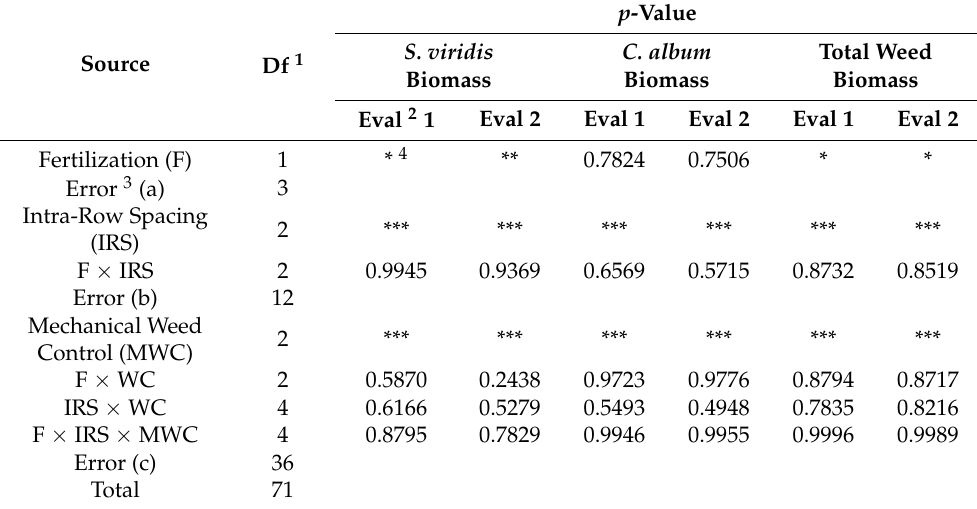
Table 2. The effects of fertilization, intra-row spacing, and mechanical weed control on the biomass of Setaria viridis (L.) P.Beauv. and Chenopodium album L., and total weed biomass. For each parameter, p -Values are shown as derived from three-factor Analysis of Variance (ANOVA) ( a = 0.05). p Source Df 1